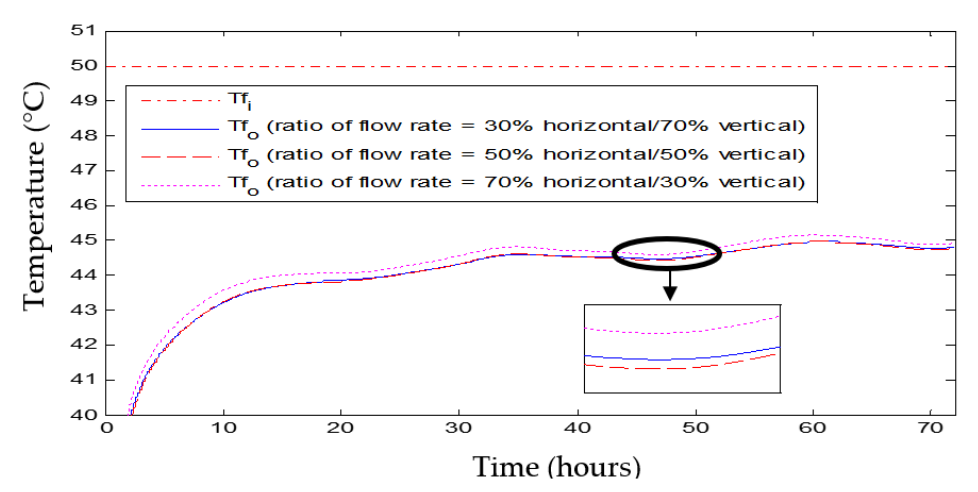
Figure 13. Profile of the outlet fluid temperature of the GHE (with a split flow operation mode) under different flow rate ratios (Adelaide case).